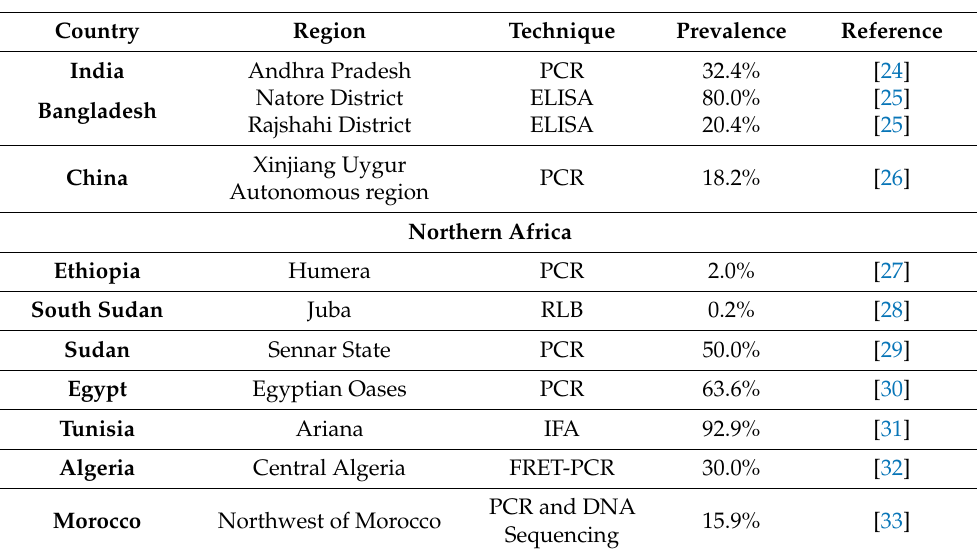
Prevalence of Theileria